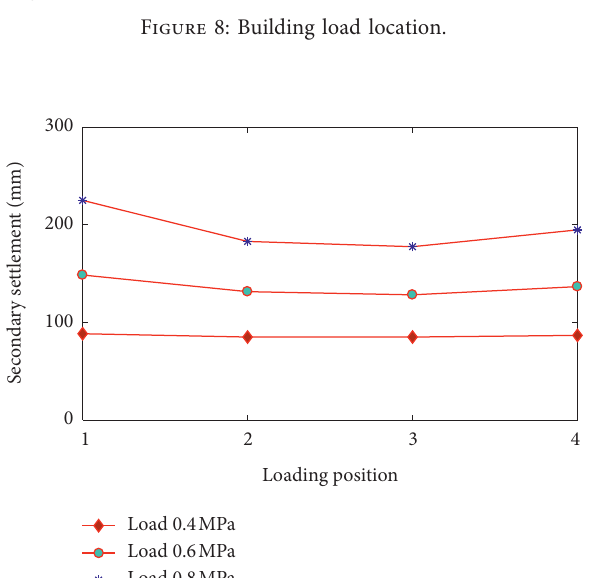
Figure 9: Relationship between load position and surface sec- ondary